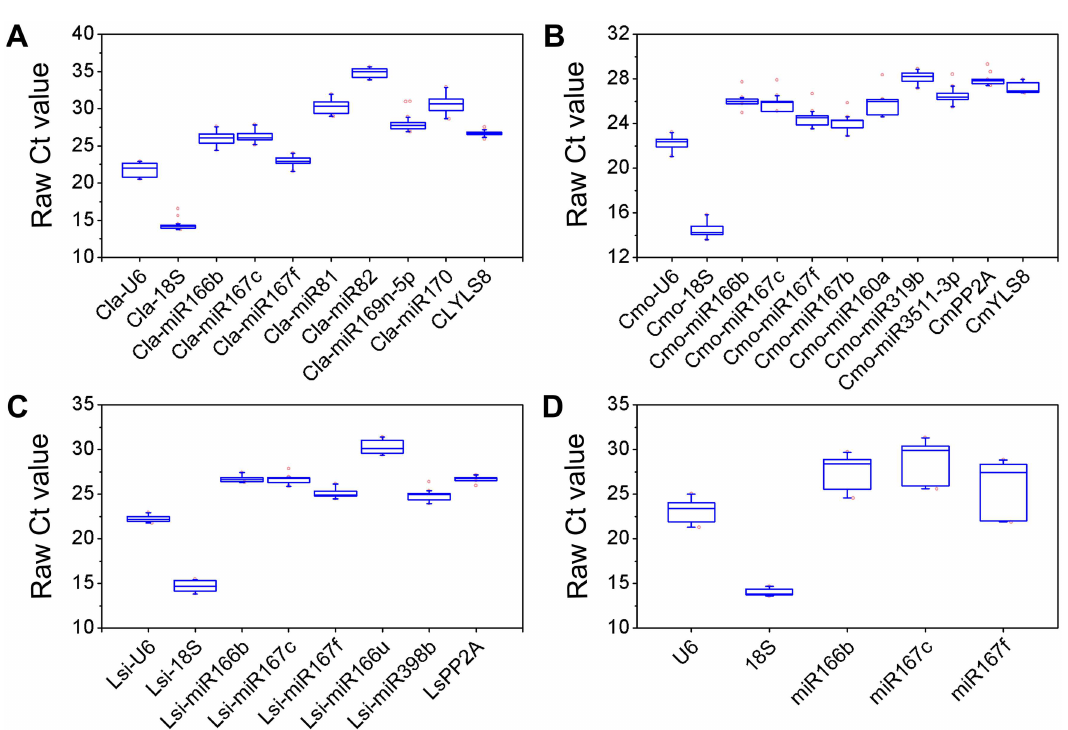
Fig 1. Box plot of the Ct values of the candidate reference genes among samples. The raw Ct values of each reference gene in samples from four datasets: (A) the leaves of different grafted watermelons under N or P starvation, (B) the roots of grafted and non-grafted squash rootstocks under N or P starvation, (C) the roots of grafted and non-grafted bottle gourd rootstocks under N or P starvation, (D) all leaves from different grafted watermelon scions and roots from grafted and non-graftedrootstocks under normal conditions. The line across the box depicts the median. The box indicates the 25/75 percentiles, and whisker caps represent the maximum and minimum values. The circles represent the